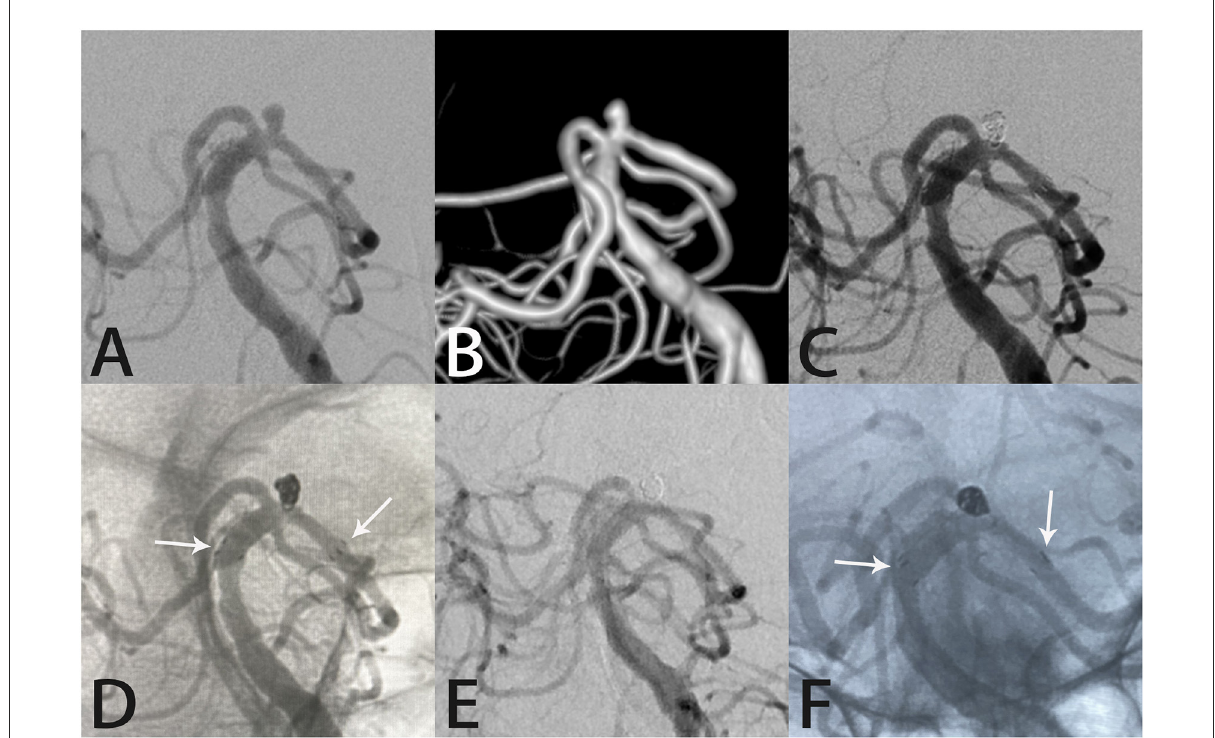
FIGURE1 Images from a 66-year-old woman with a tiny left posterior cerebral artery aneurysm. Digital subtraction angiography with three-dimensional reconstruction images demonstrated a left posterior cerebral artery aneurysm (A,B) . Angiography immediately after Atlas stent-assisted coiling showed complete aneurysm occlusion (C) . An unsubtracted image shows the three radiopaque markers (white arrows) at the proximal and distal ends of the Atlas stent (4.0 × 15mm) and the coils within the aneurysm sac (D) . Follow-up angiography 6 months later showed complete aneurysm occlusion, parent artery patency, stability of the Atlas stent (white arrows indicate the ends of the stent), and the coils densely packed within the aneurysm sac (E,F)